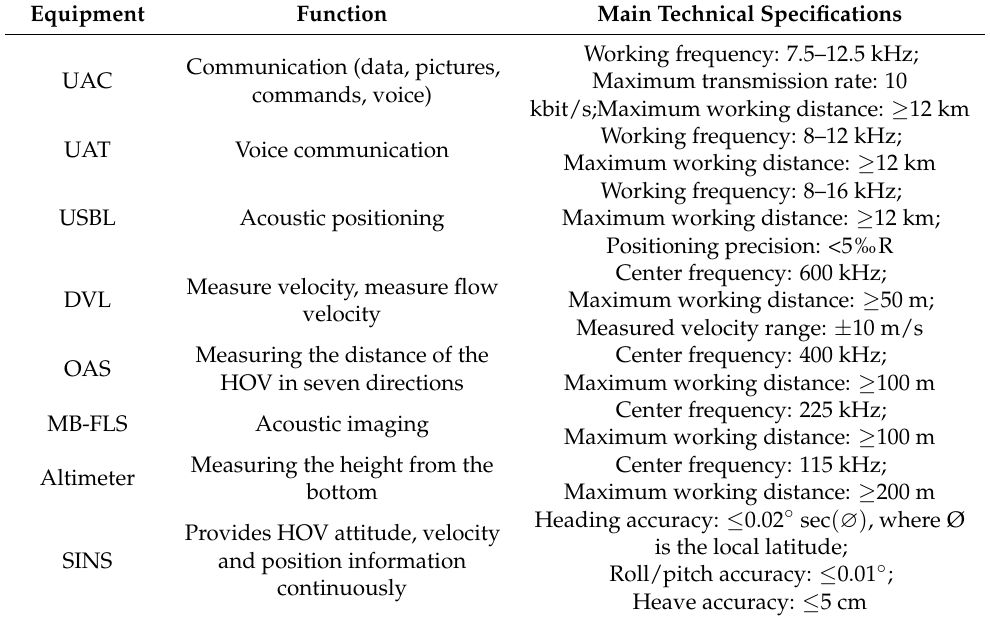
Table 1. Functions and main technical specifications of the acoustic system’s